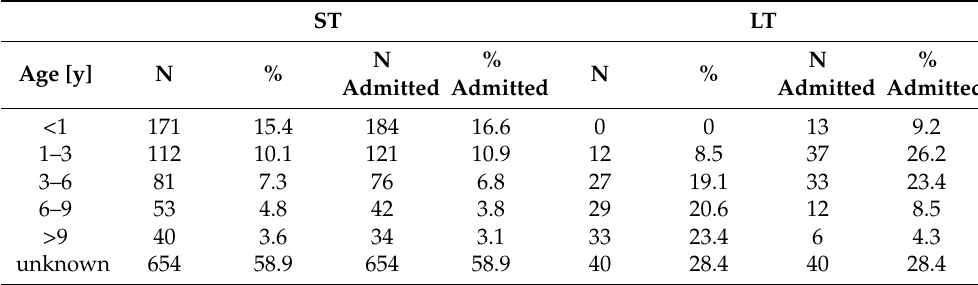
Table 3. Descriptive statistic of age and age when being admitted for LT and ST dogs including dogs for which no information about the age was available. The ST group only included already rehomed dogs with a maximum length of stay of five